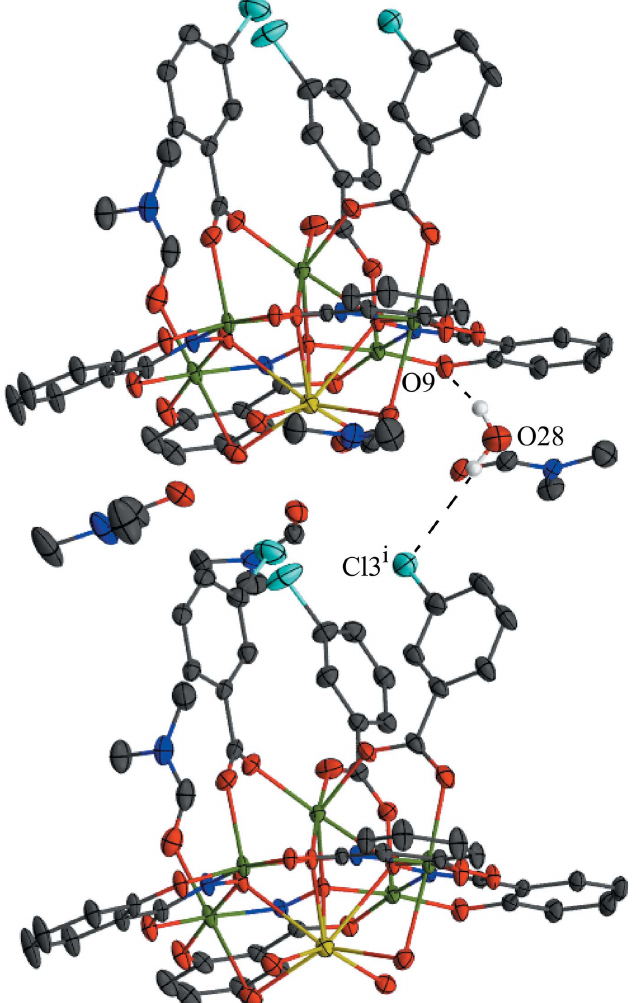
Figure 6 Intermolecular hydrogen bonding in 2 between the partially occupied water molecule and two neighboring MCs [symmetry code: (i) x (cid:3) 1, y , z ]. For clarity only the hydrogen atoms (white) of the water molecule associated with O28 have been included and only the atoms involved in the interaction have been labeled. See Fig. 1 for additional display